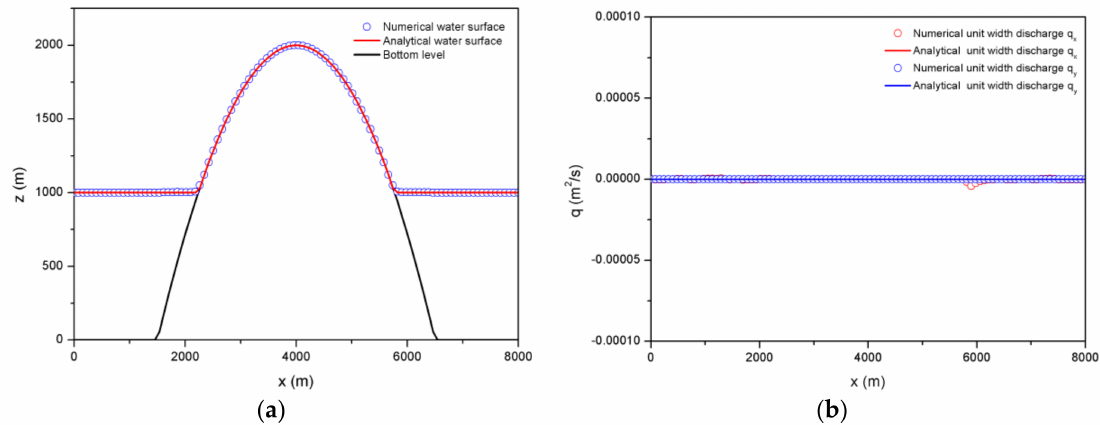
Figure 6. Comparisons between numerical and analytical results at t = 1500 s: ( a ) water surface; ( b ) unit width discharges in x and y directions.